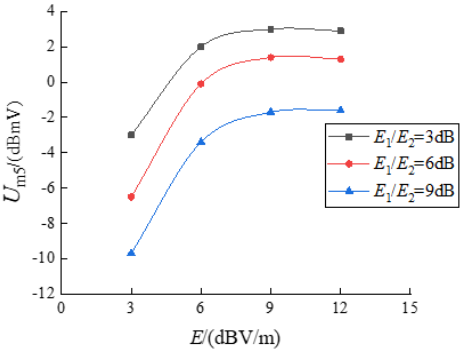
Figure 5. Variation curve of the IMFA − 5 with the interference field strength.